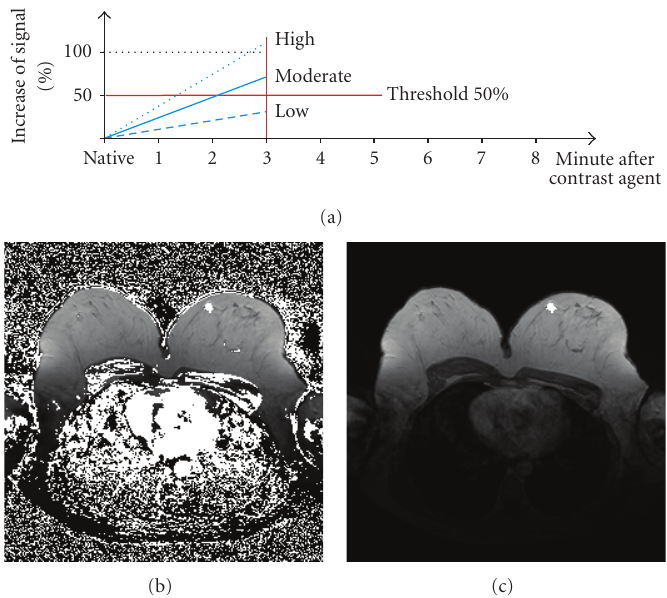
Figure 3: Conventional segmentation method. (a) Threshold segmentation. (b) Classification based on threshold segmentation: pixels exhibiting time signal intensity curves above a given threshold are white. (c) The lesion is determined based on region growing.